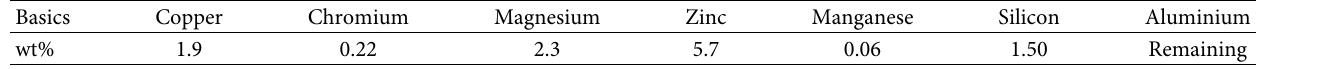
Table 1: Chemical arrangement of AA 7475 alloy.